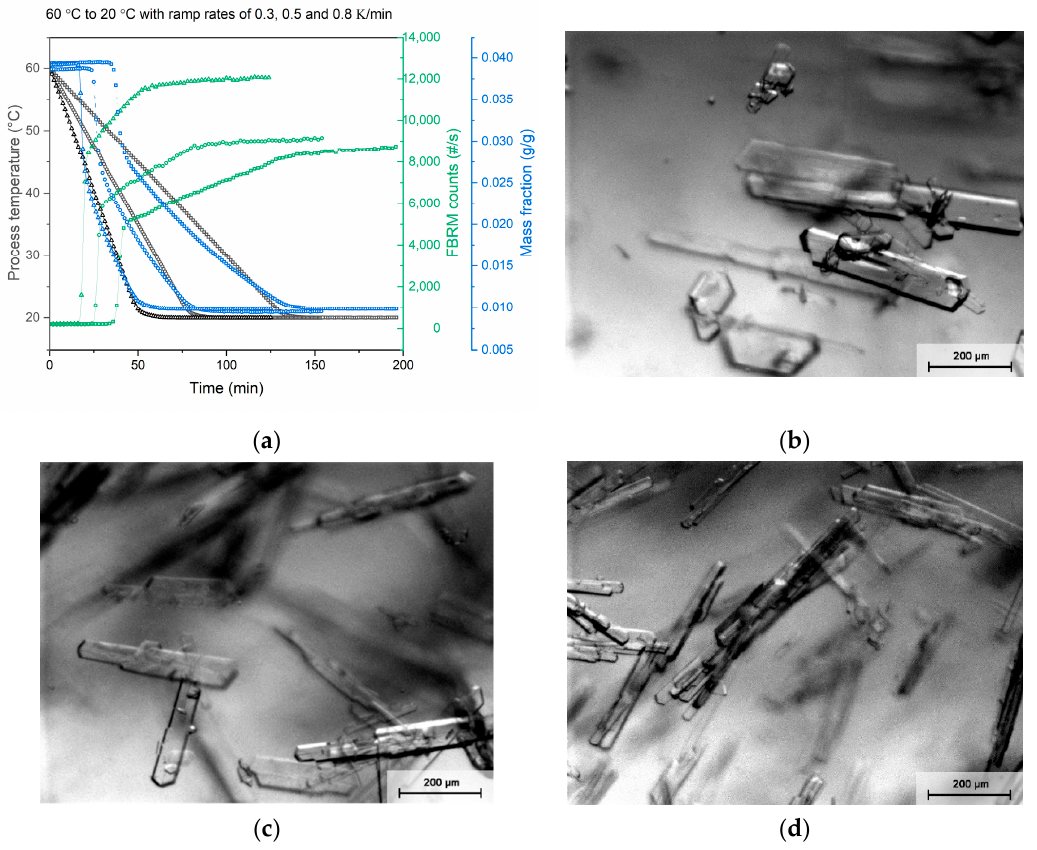
Figure 2. ( a ) Temperature ― , FBRM counts ― , and concentration ― profiles for experiments LC-1 to LC-3 at different cooling rates of 0.3 K/min, 0.5 K/min, and 0.8 K/min; PVM image of final product crystals of ( b ) LC-1, ( c ) LC-2, and ( d ) LC-3.